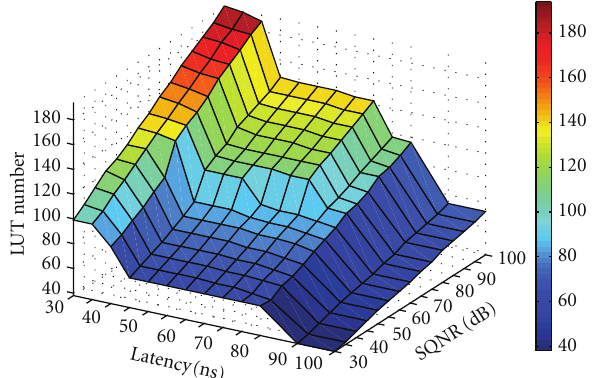
Figure 9: Implementation cost according to the accuracy and timing constraint for WCDMA searcher module.